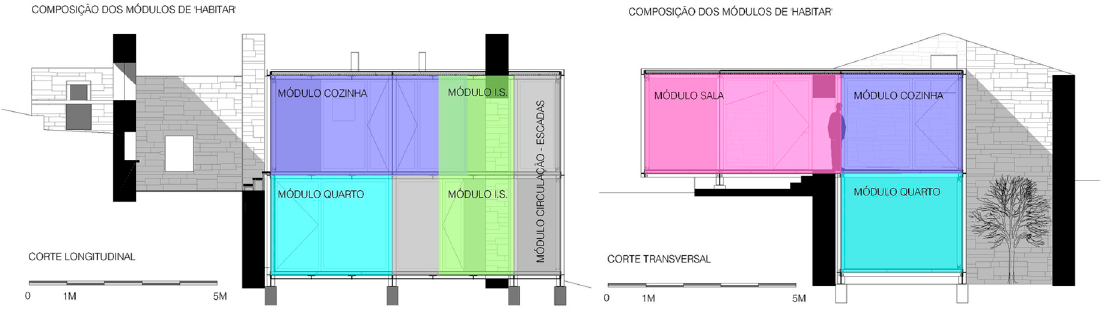
Figure 3. Schemes of the composition of the “living” modules (cuts).